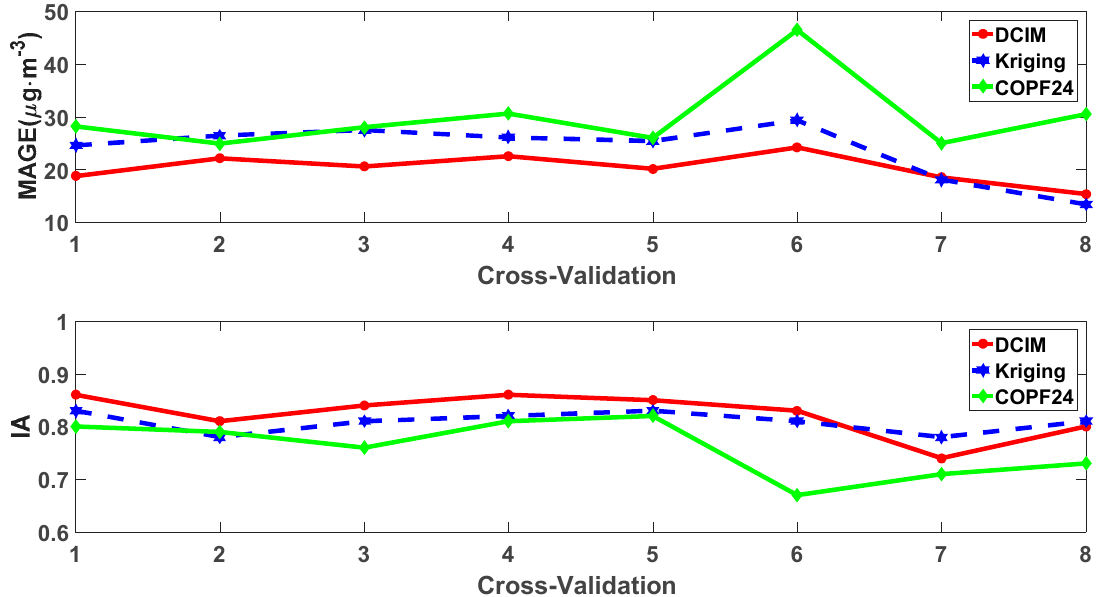
Figure 2. Interpolation errors in checked samples of different methods for the 8-fold cross-validation experiments on 8–11 November 2014.